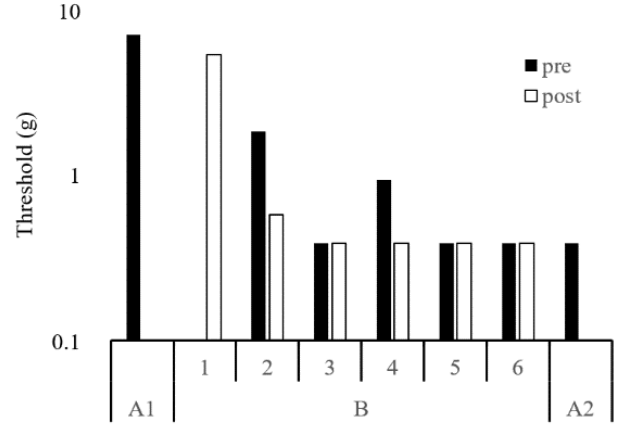
Figure 6. Tactile pressure sensitivity threshold in the right hallux. The vertical axis is logarithmic.